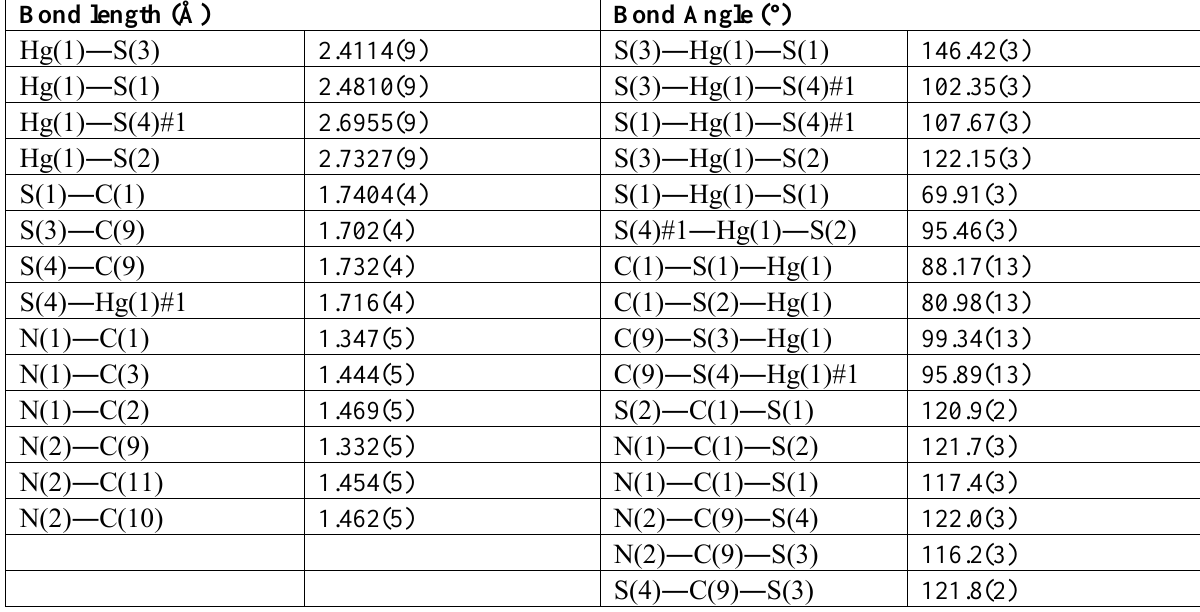
H )(CH )NCS ] Hg 6 5 3 2 4 2